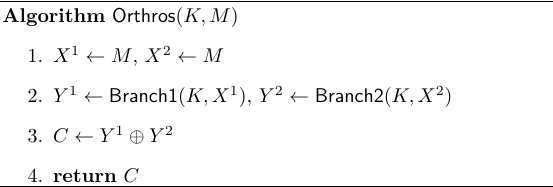
Figure 6: Processing algorithm of Orthros